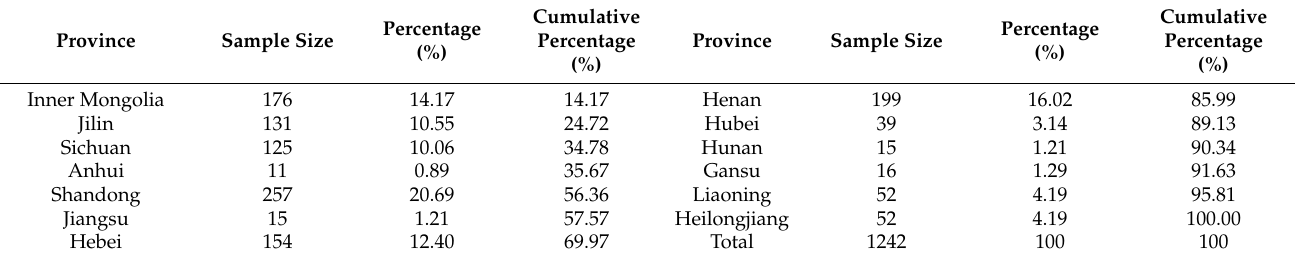
Table 1. Sample distribution unit: